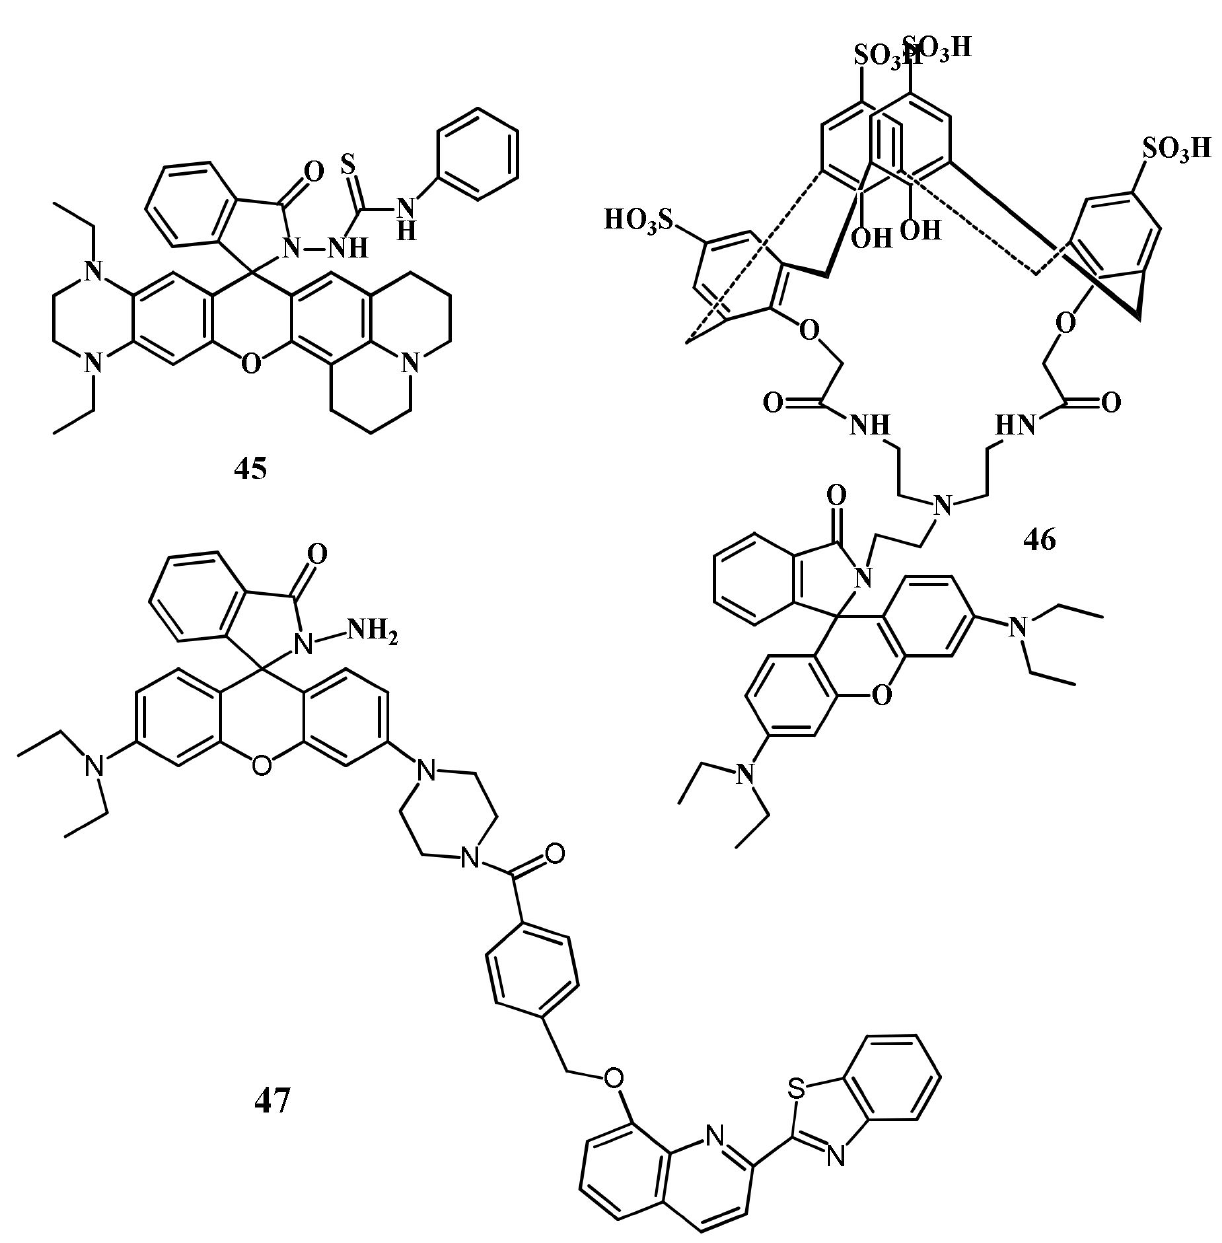
Figure 15. Molecular structures of the sensors 45 to 47